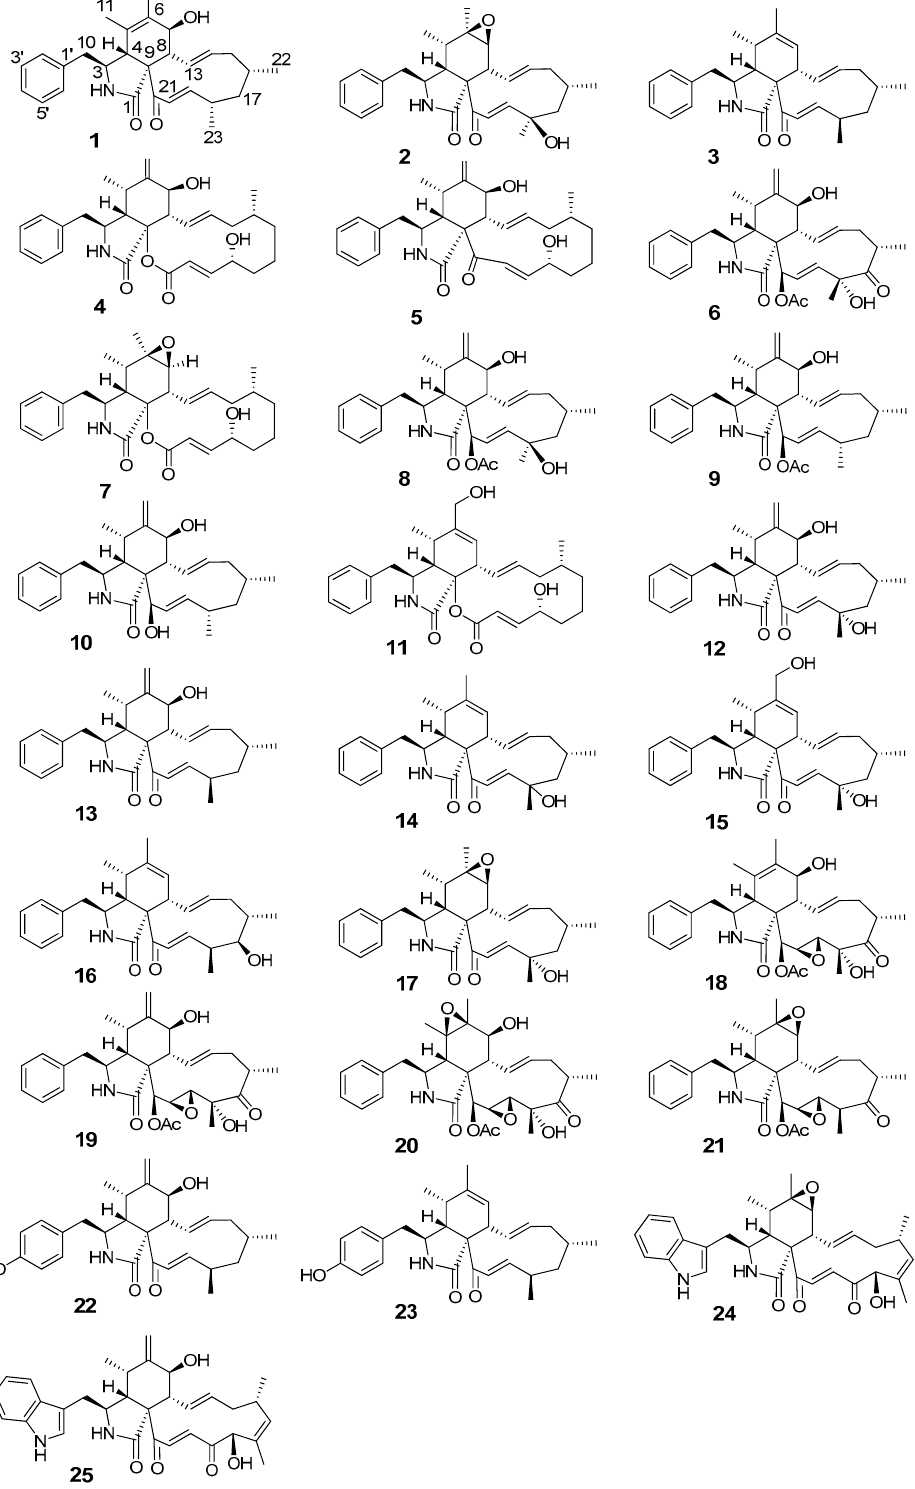
Figure 1. Chemical structures of cytochalasans employed in this study.